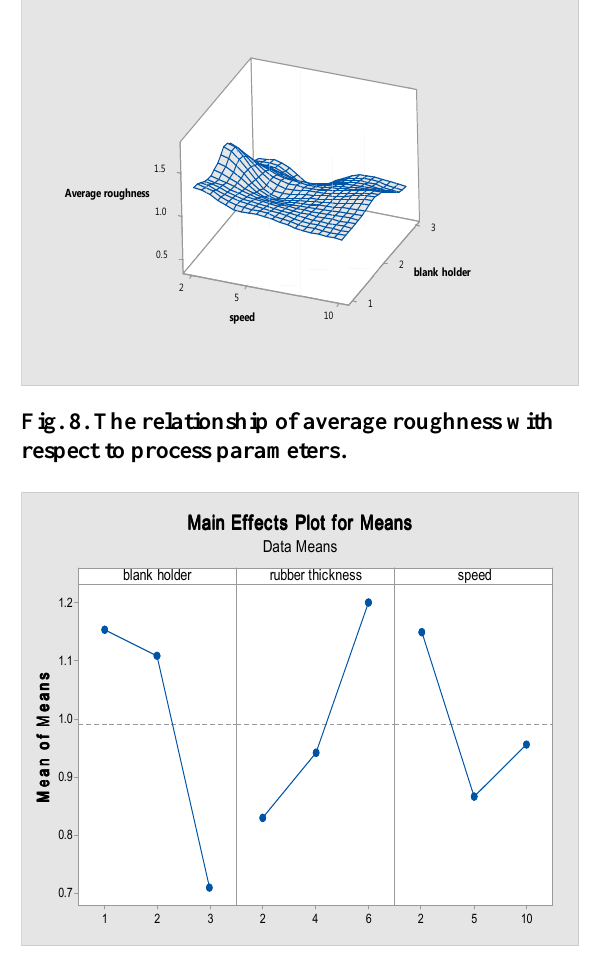
Fig. 9. The relationship of mean of mean for each process